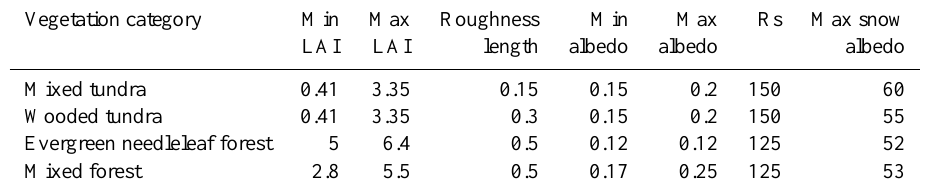
Table 2. Key parameters for the dominant vegetation categories used in Experiment 1 and Experiment 2 (Ex 1 and Ex 2). Vegetation category Min Max Roughness Min Max Rs Max snow LAI LAI length albedo albedo albedo Mixed tundra 0.41 3.35 0.15 0.15 0.2 150 60 Wooded tundra 0.41 Evergreen needleleaf forest 5 Mixed